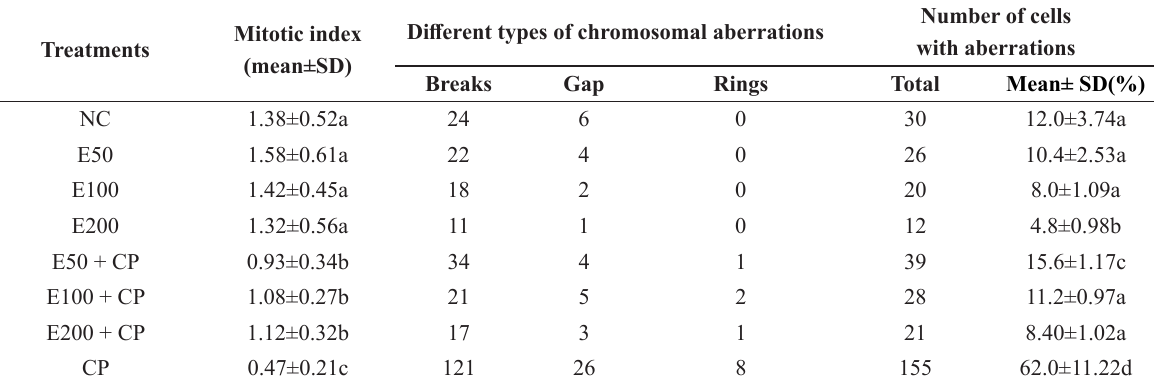
Number and mean percentages of chromosomal aberrations and mean number of mitotic index in mice bone-marrow cells after treatment of the hidroethanolic extract of H.courbaril seed with or without CP. They were analyzed 2000 erythrocytes polychromatics (EPC) for each experimental and control